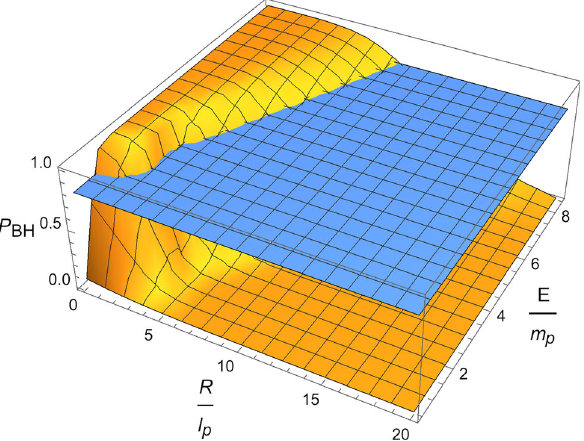
Fig. 9 Probability for two colliding shells with momenta P 1 = P and P 2 = − P to form a black hole as a function of the radius R and the total energy E (in Planck units). The blue plane delimits the region where the probability P BH > 0 .